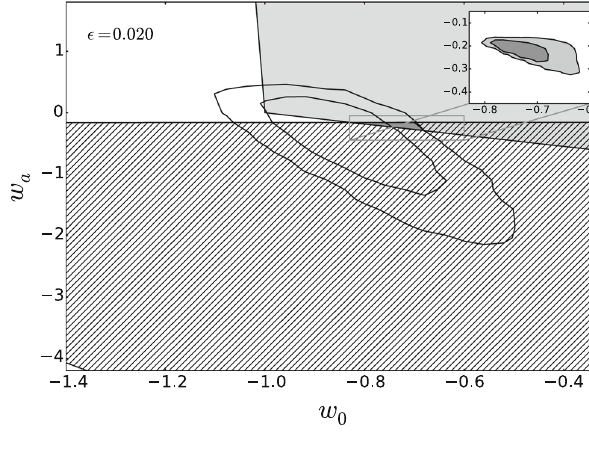
parameter is (cid:8) γ = 2 . 469 × 10 − 5 h − 2 for a CMB temperature T CMB = 2 . 725